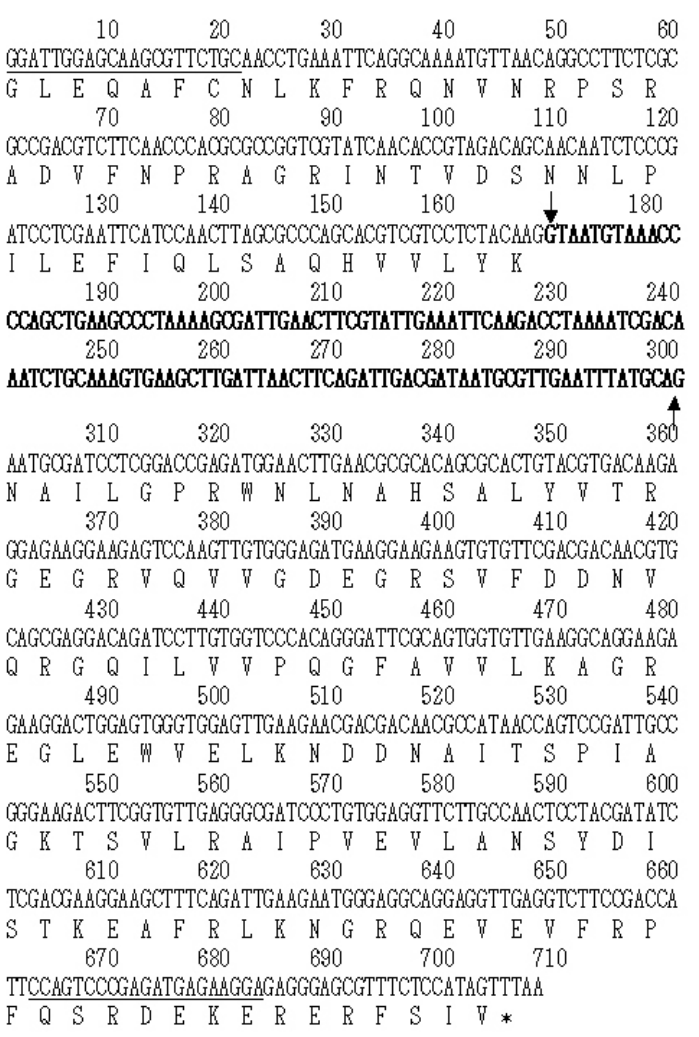
FIGURE 4. Nucleotide and deduced amino acid sequence of the genomic DNA of F. esculentum encoding the major allergenic protein: Fag e1. The forward and reverse primers used to amplify the genomic DNA are underlined. The intron sequences (130 bp) are in bold letters. The arrows indicate the characteristic GU(cid:133)AG dinucleotide combinations at the intron